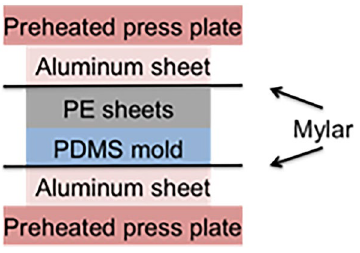
Figure 6. Components used in moulding assembly. Stainless steel plates supported the assembly, followed by an aluminium plate, mylar backing, the PDMS mould, and the PE sheets to be